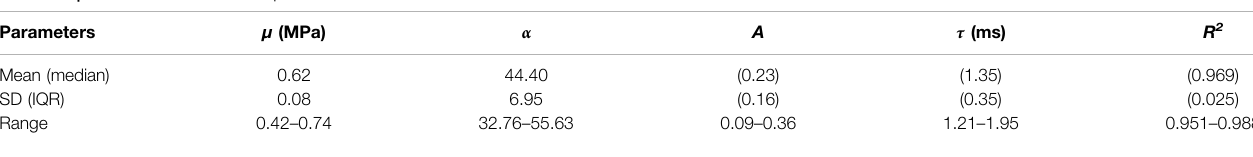
TABLE 4 | The determined material parameters.